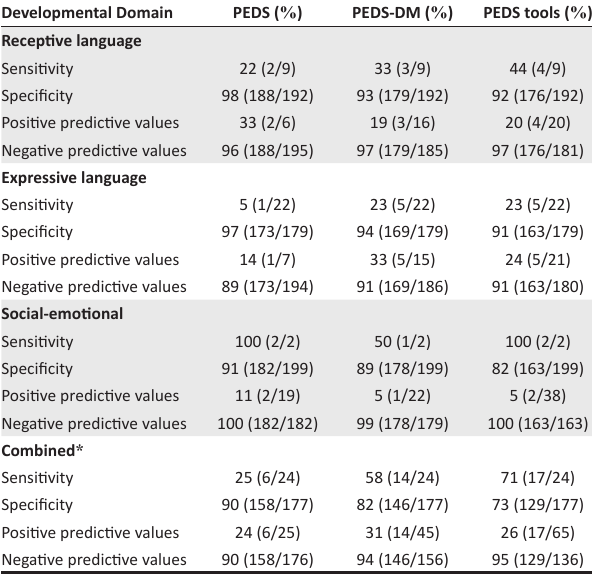
TABLE 2: Developmental domain–specific performance of the PEDS tools in comparison to the RITLS. Developmental